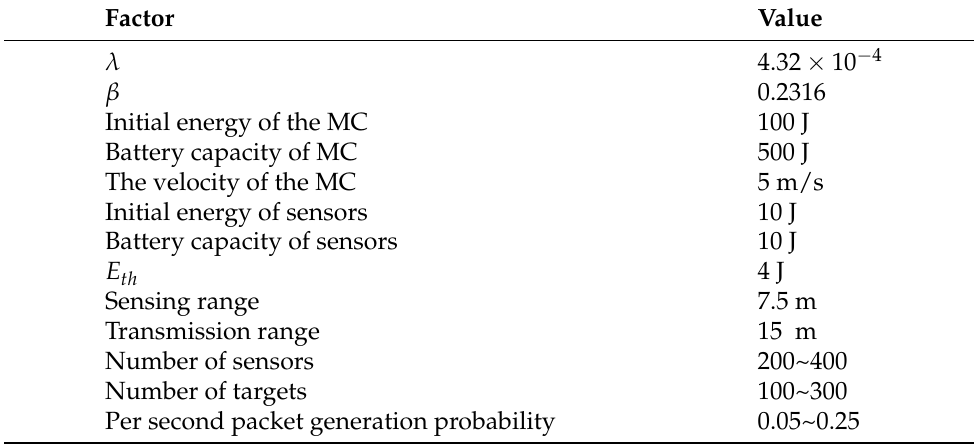
Table 7. System parameters.